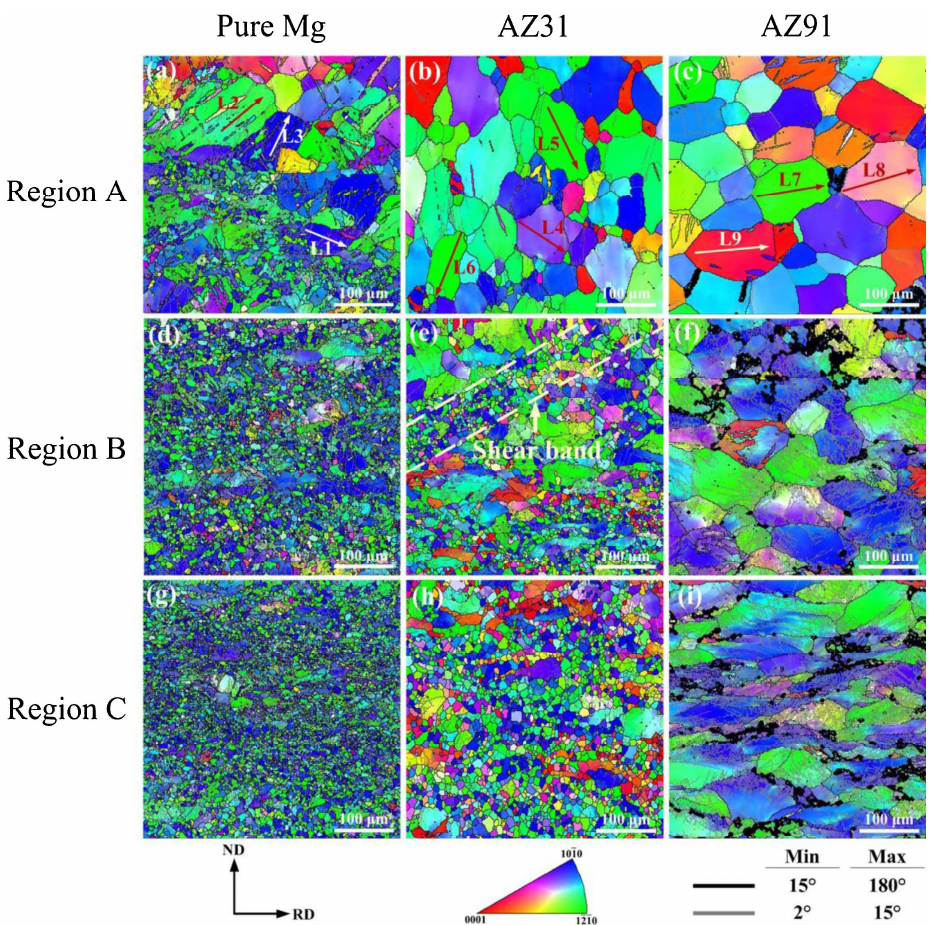
Figure 4. Electron Back Scattered Diffraction’s Inverse pole figure maps of rolled Mg, AZ31 and AZ91 alloys at different deformation stages: ( a – c ) Region A—initial ( d ‒ f ) Region B—medium, ( g – i ) Region C—final [49].